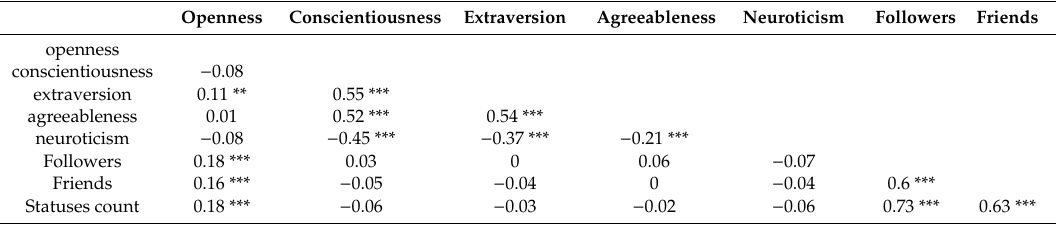
Table 3. Correlation